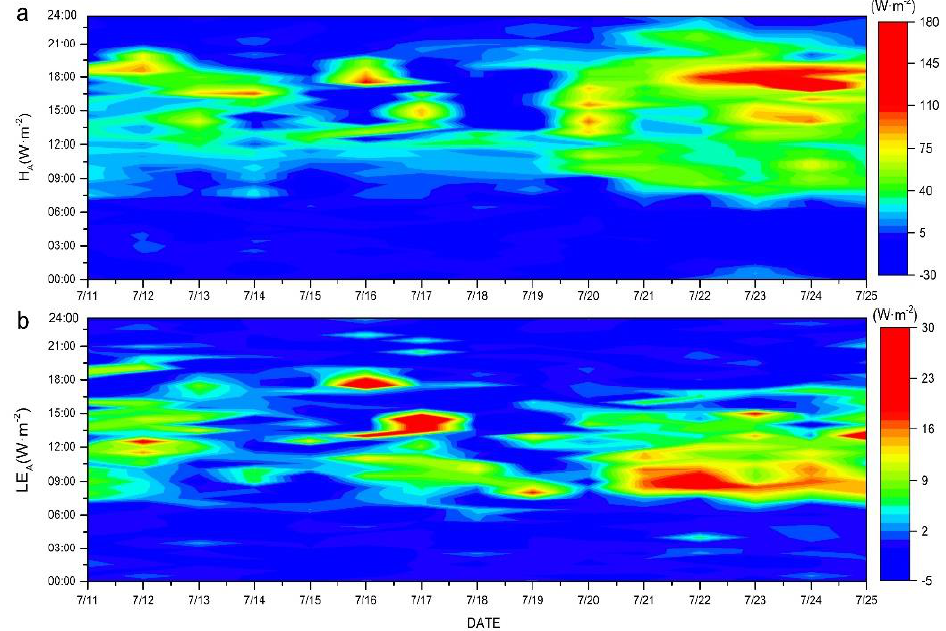
Figure 5. Colour contours of 30-min averaged ( a ) horizontal sensible heat advection ( b ) horizontal latent heat advection observed at 2 m from 11/July to 25/July in FOF.